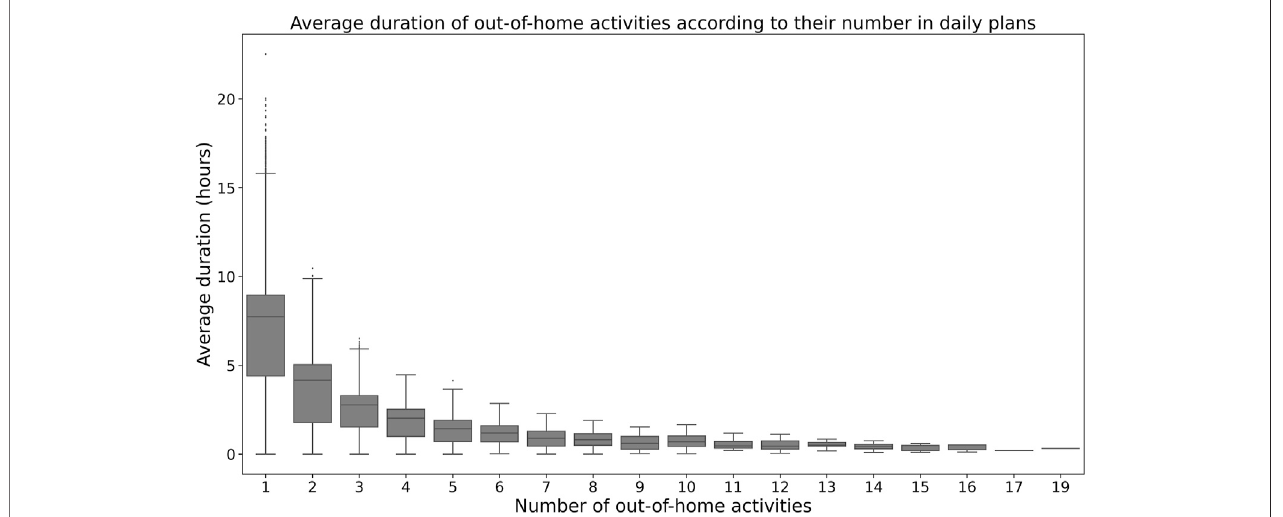
FIGURE 13 | Distribution of the average duration of out-of-home activities according to their number in daily plans in the population of Montreal.